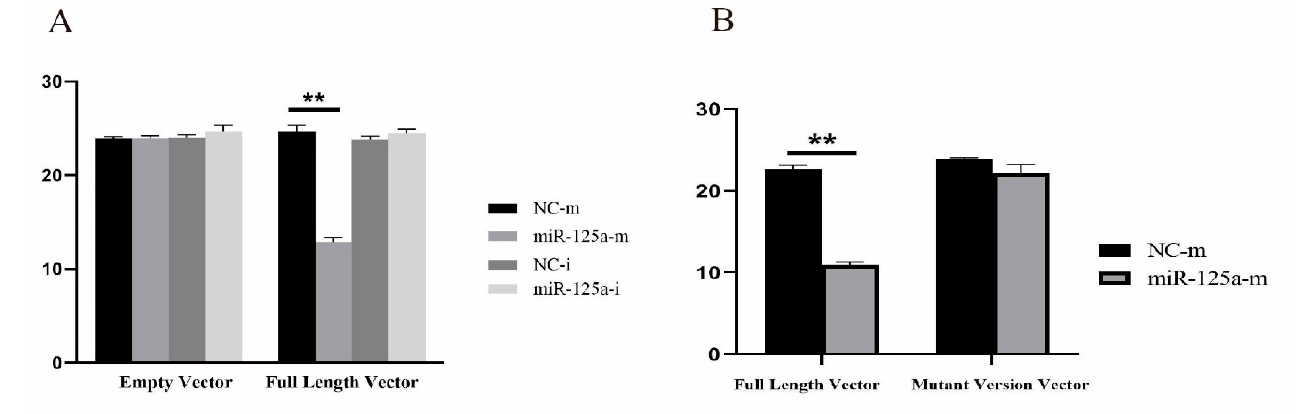
Figure 2. MicroRNAs suppressed the expression of SAA1 by binding to the 3 ′ -UTR target sequence. Luciferase activity in HEK293 cells co-transfected with miRNA mimic, miRNA inhibitor, miRNA control and empty vector for the SAA1 3 ′ -UTR. Luciferase activity was assayed 24 h after transfection. All luciferase values were normalized to Renilla luciferase. Black columns represent the luciferase activity upon co-transfection with miRNA-mimic control. Middle gray columns represent the luciferase activity upon co-transfection with miRNA-inhibitor control. Dark gray columns represent the luciferase activity upon co-transfection with miRNA mimic. Light gray columns represent the luciferase activity upon co-transfection with miRNA inhibitor. ( A ) represents the luciferase activity of SAA1 after over- or under-expression of miR-125a compared with controls; ( B ) represents the luciferase activity of SAA1 after transfecting the mutant vector and miR-125a, compared with control. ** Very significant difference between the control and the treatment ( p < 0.01).